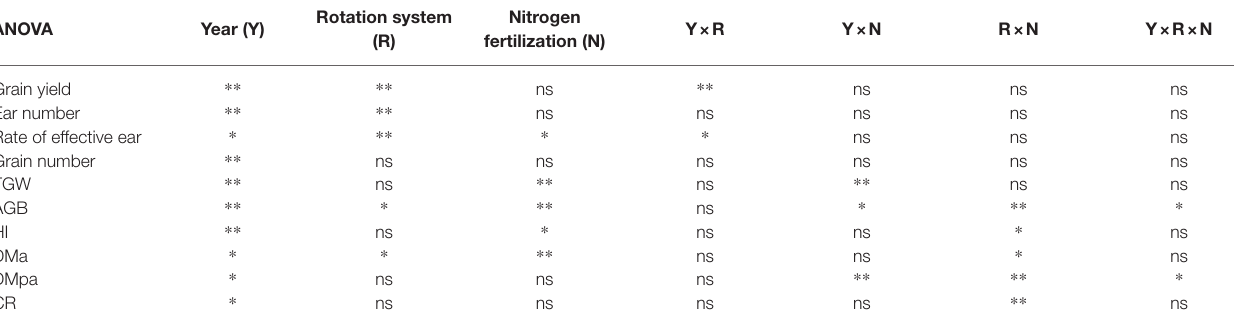
TABLE 1 | Combined analysis of variances for grain yield, agronomical and physiological traits of winter wheat. Rotation system ANOVA Year (Y)